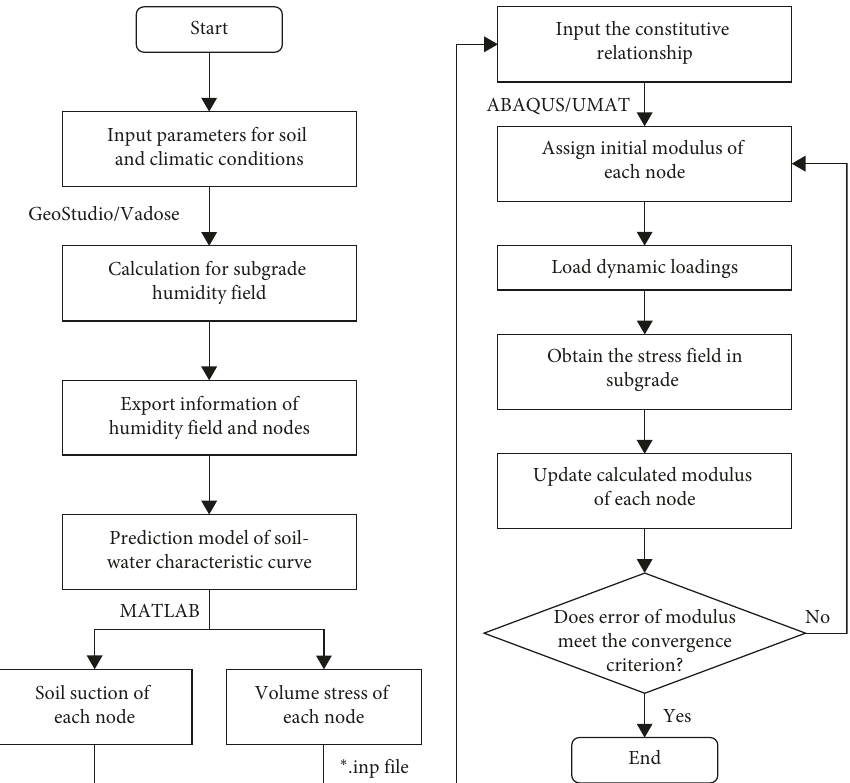
Figure 1: Flow chart for the calculation of the nonuniform modulus